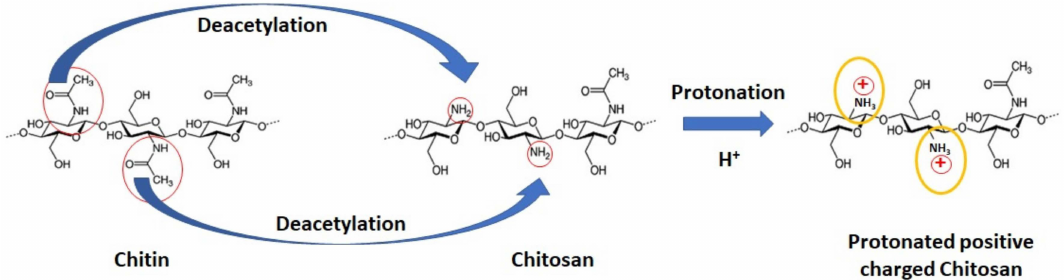
Figure 1. Structures for chitin, the noncharged form of chitosan, and protonated positive-charged